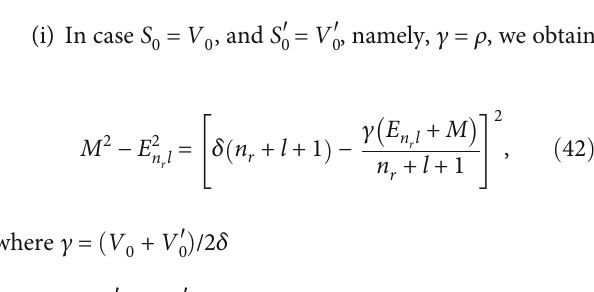
= 0 : 035 and (c, d) the parameters M = 10 , V 0